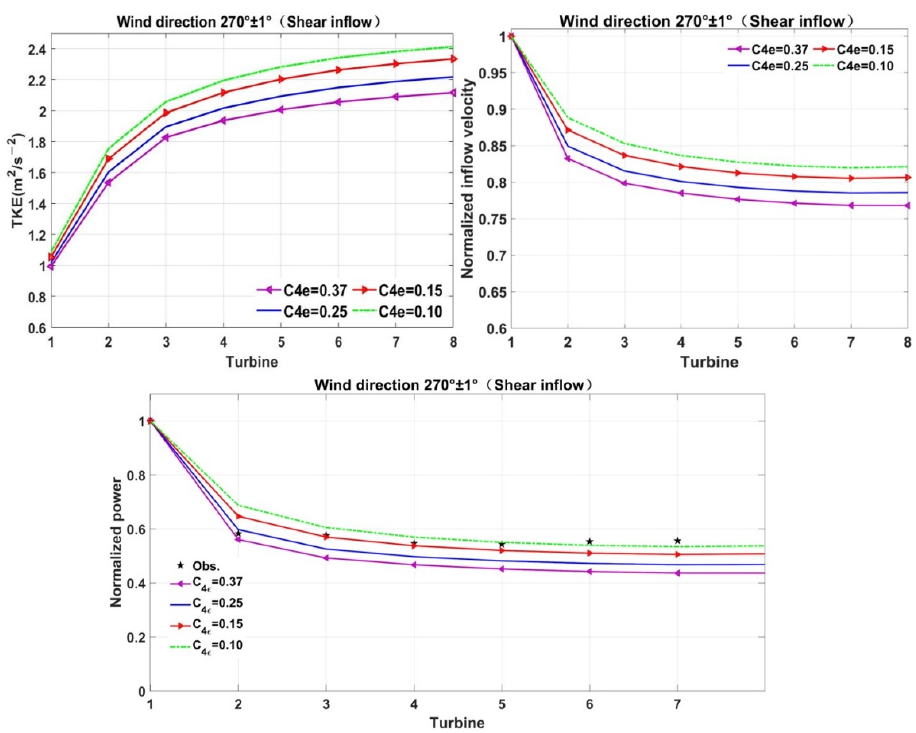
Figure 15. Effects of different C 4 ε values on TKE, inflow wind speed and power output under shear inflow conditions when the incoming wind direction is 270 ± 1°.